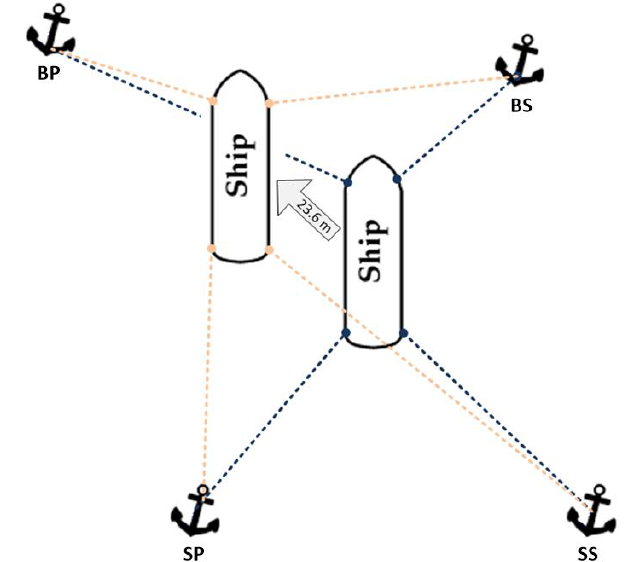
Figure 12. Visualisation of the ship ’ s trajectory.